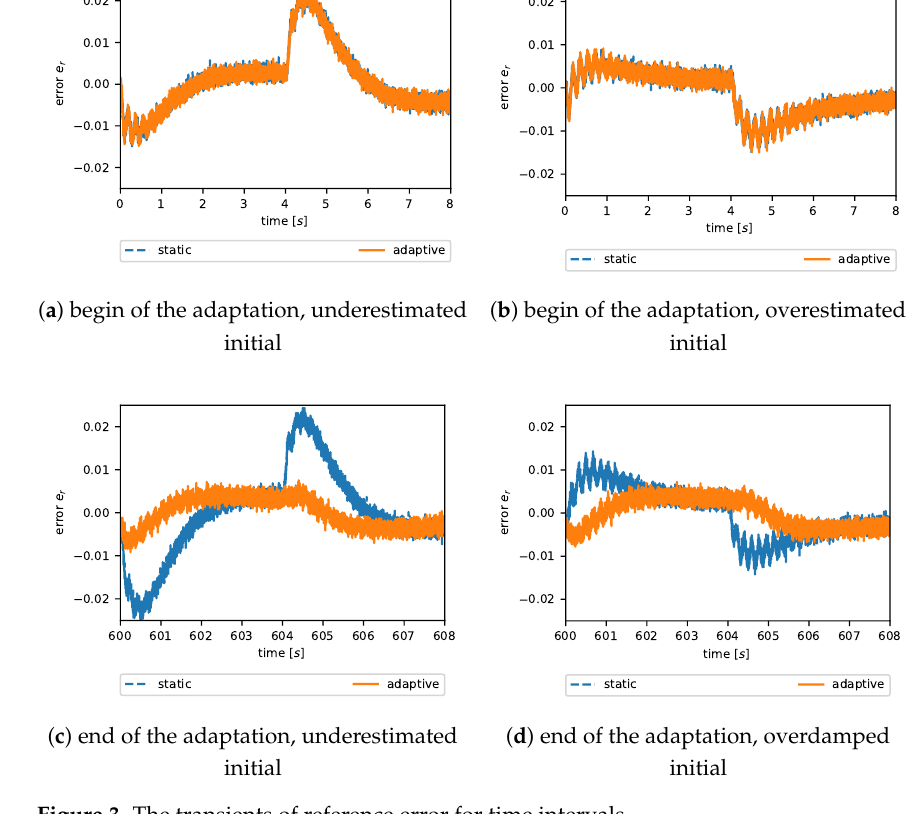
Figure 3. The transients of reference error for time